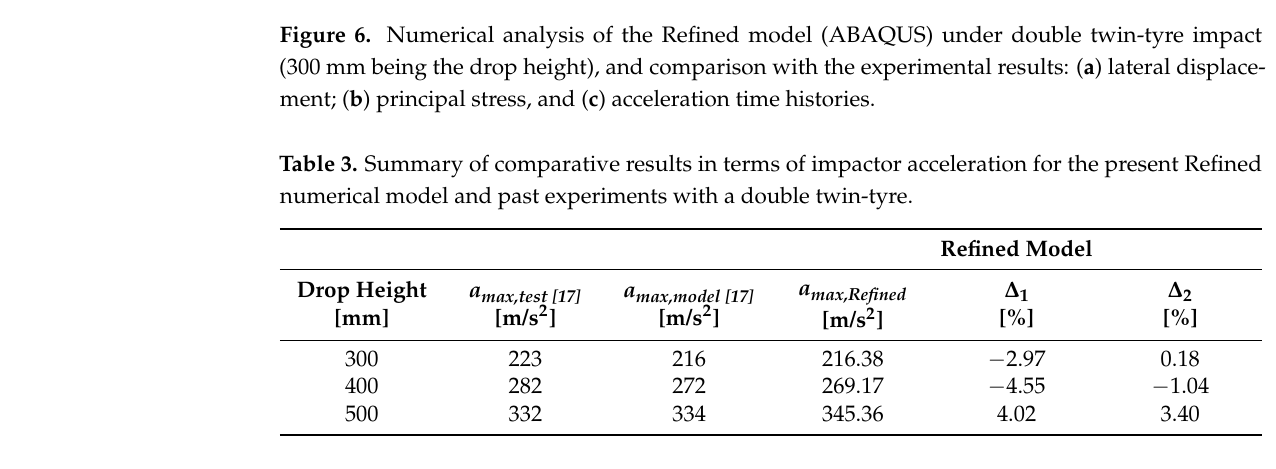
Table 3. Summary of comparative results in terms of impactor acceleration for the present Refined numerical model and past experiments with a double twin-tyre.